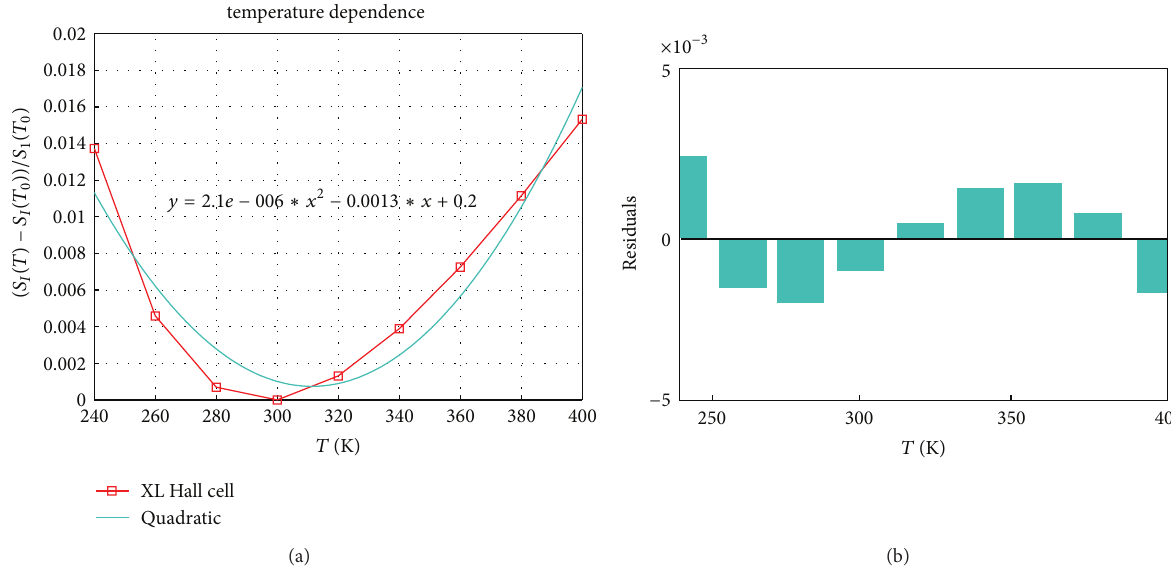
Figure 13: The simulated relative variation of the current-related sensitivity versus the temperature (a) and the residuals of the fitting curve